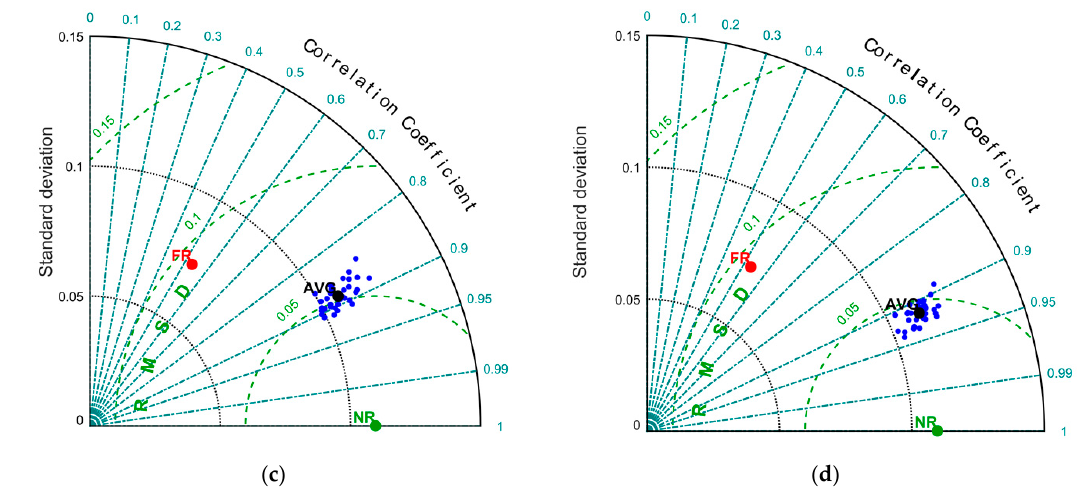
Figure 7. Representation of the ensemble of the analyses obtained from datasets of velocity measurements from, respectively, 40 ( a ), 60 ( b ), 80 ( c ), and 150 ( d ) observation points randomly positioned (blue points), Free Run (red point), and Nature Run (green point) in the first assimilation window.